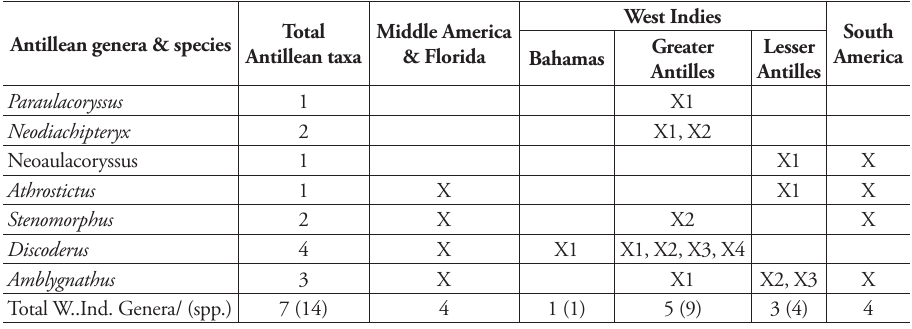
Table 7. Geographical distribution of the Selenophorine genera and species in the West Indies, excluding Selenophorus ( sensu lato